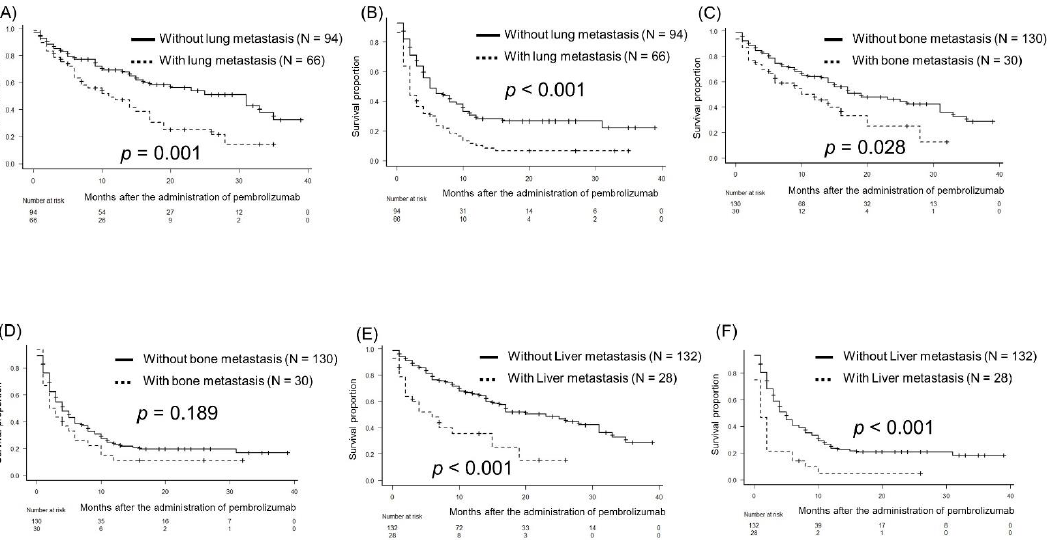
Figure 3. Kaplan-Meier curves illustrating overall (OS) and progression-free survival (PFS): ( A , B )